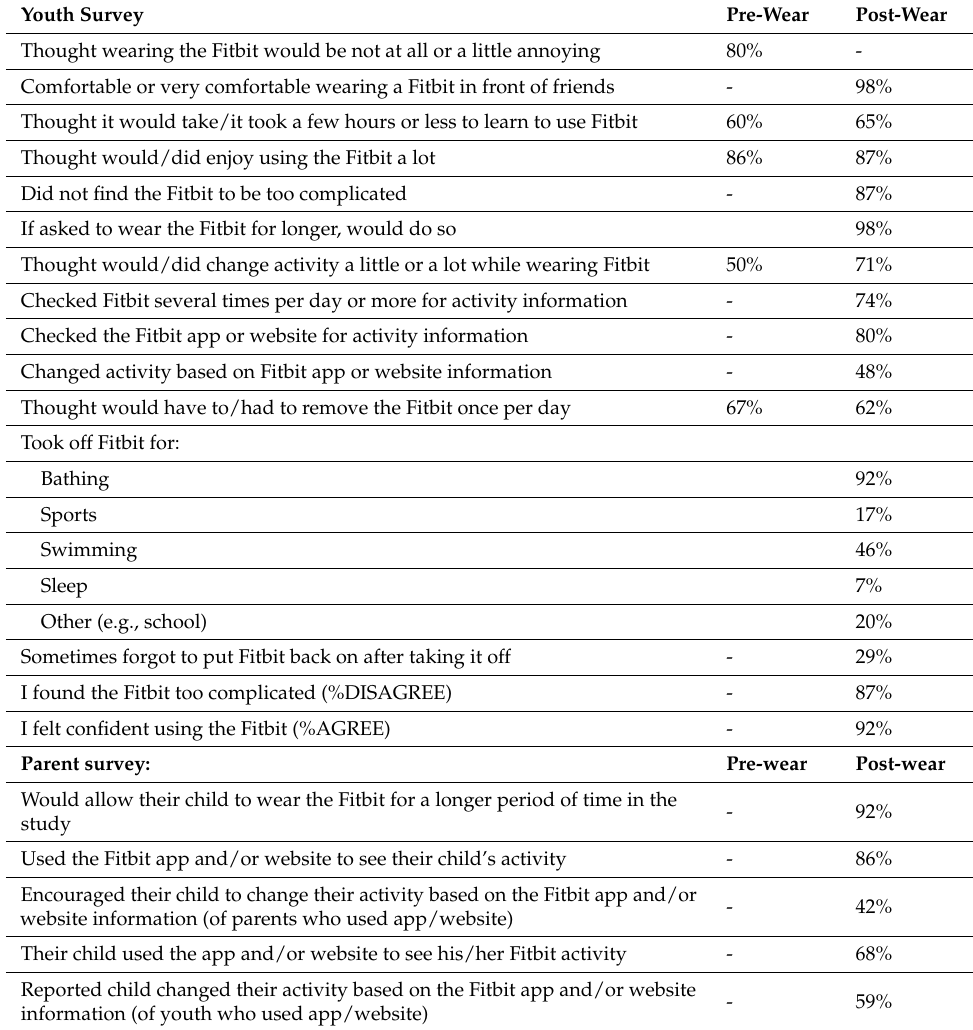
Table 2. Subjective experience: acceptability, behavioral reactivity, and compliance reports by Youth and Parent before and after the 3-week Fitbit wear period.